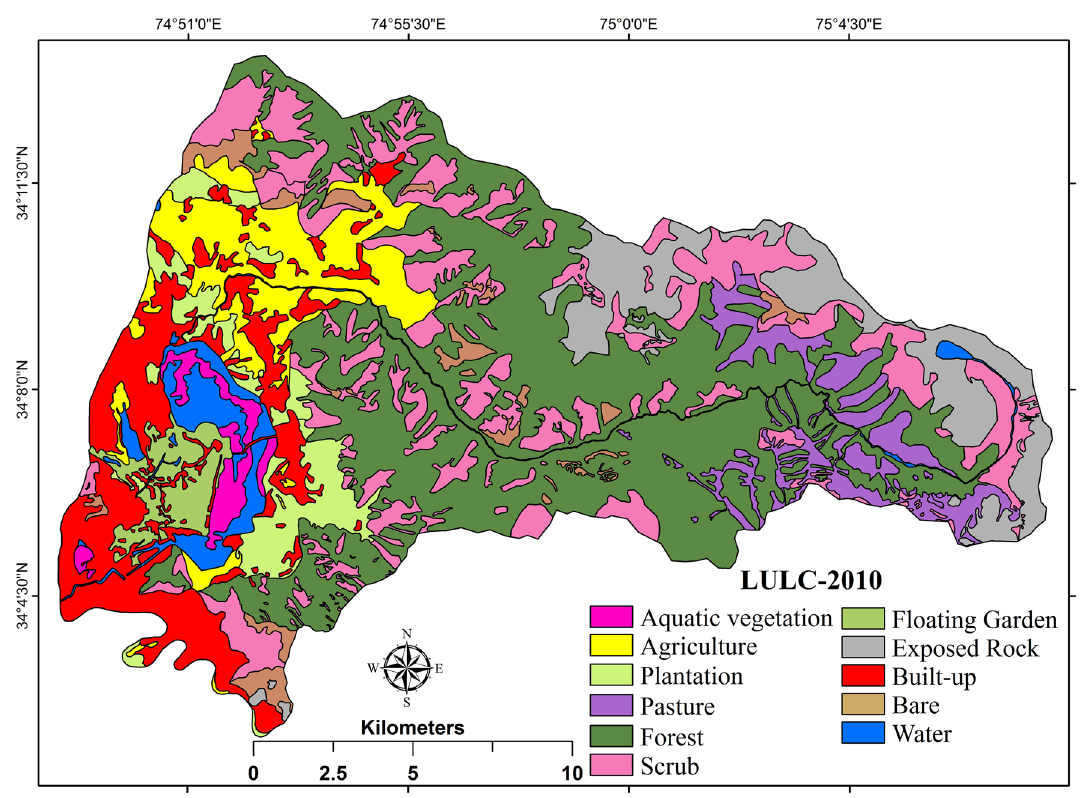
Fig. 6 LULC map of